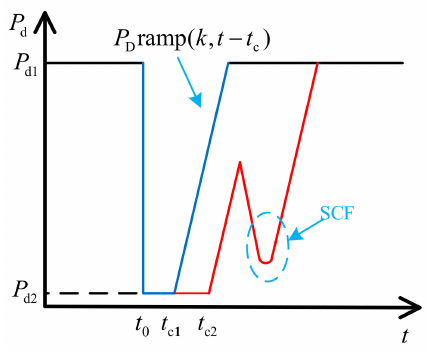
Figure 8. DC power recovery speed